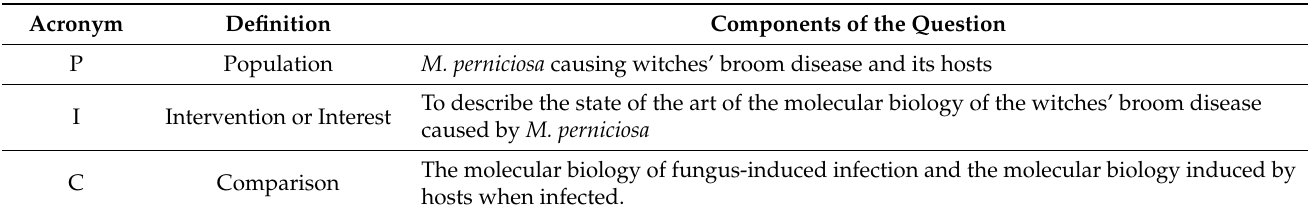
Table 2. Description of the PICOS strategy used in the systematic